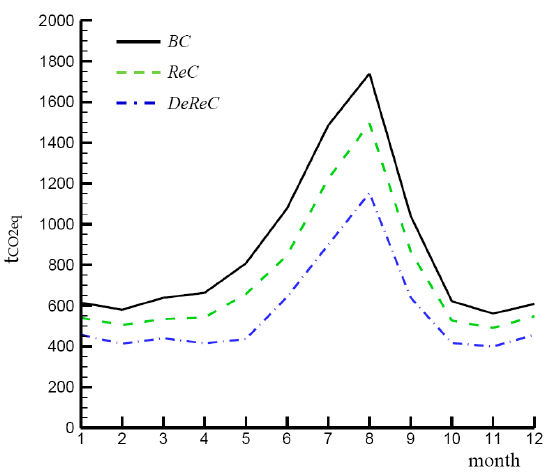
Figure 11. Monthly based curves for equivalent carbon dioxide emissions in BC (solid black line) ReC (dashed green line) and DeReC (dashed-dotted blue line), accounting for water shipping emissions in BC and ReC.